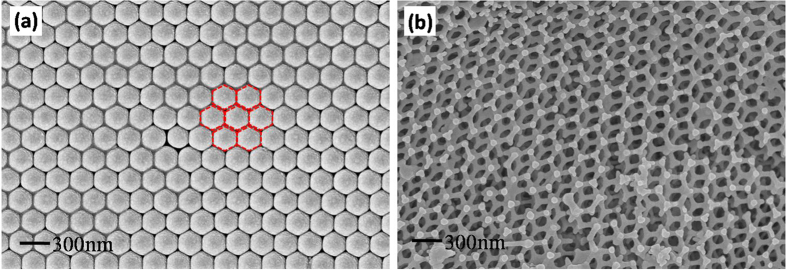
SEM images of (a) PS colloidal crystal template, (b) 3DOM Mn2O3 skeleton.